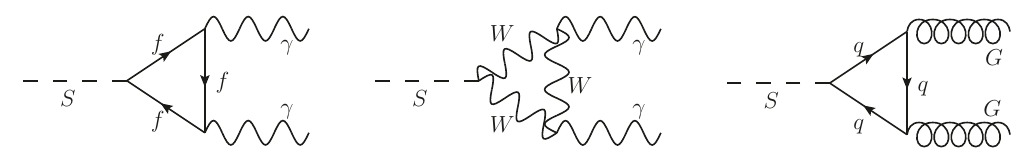
Figure 11 . Diagrams of the interaction of the scalar S with photons and